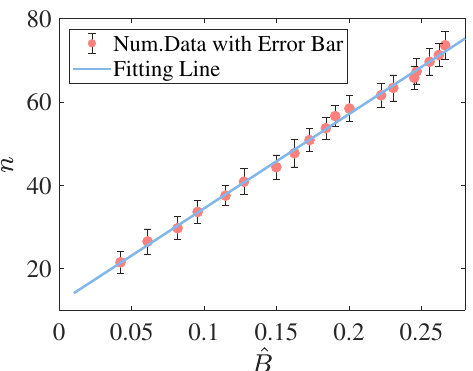
Figure 5. Linear relation between the vortex number and the magnetic field at the ‘trapping’ time. Red dots are numerical data while blue lines are from the best fit. Error bars denote the standard deviations. We count the vortex number n as the order parameter saturates equilibrium, and this relation is averaged over 200 times of independent